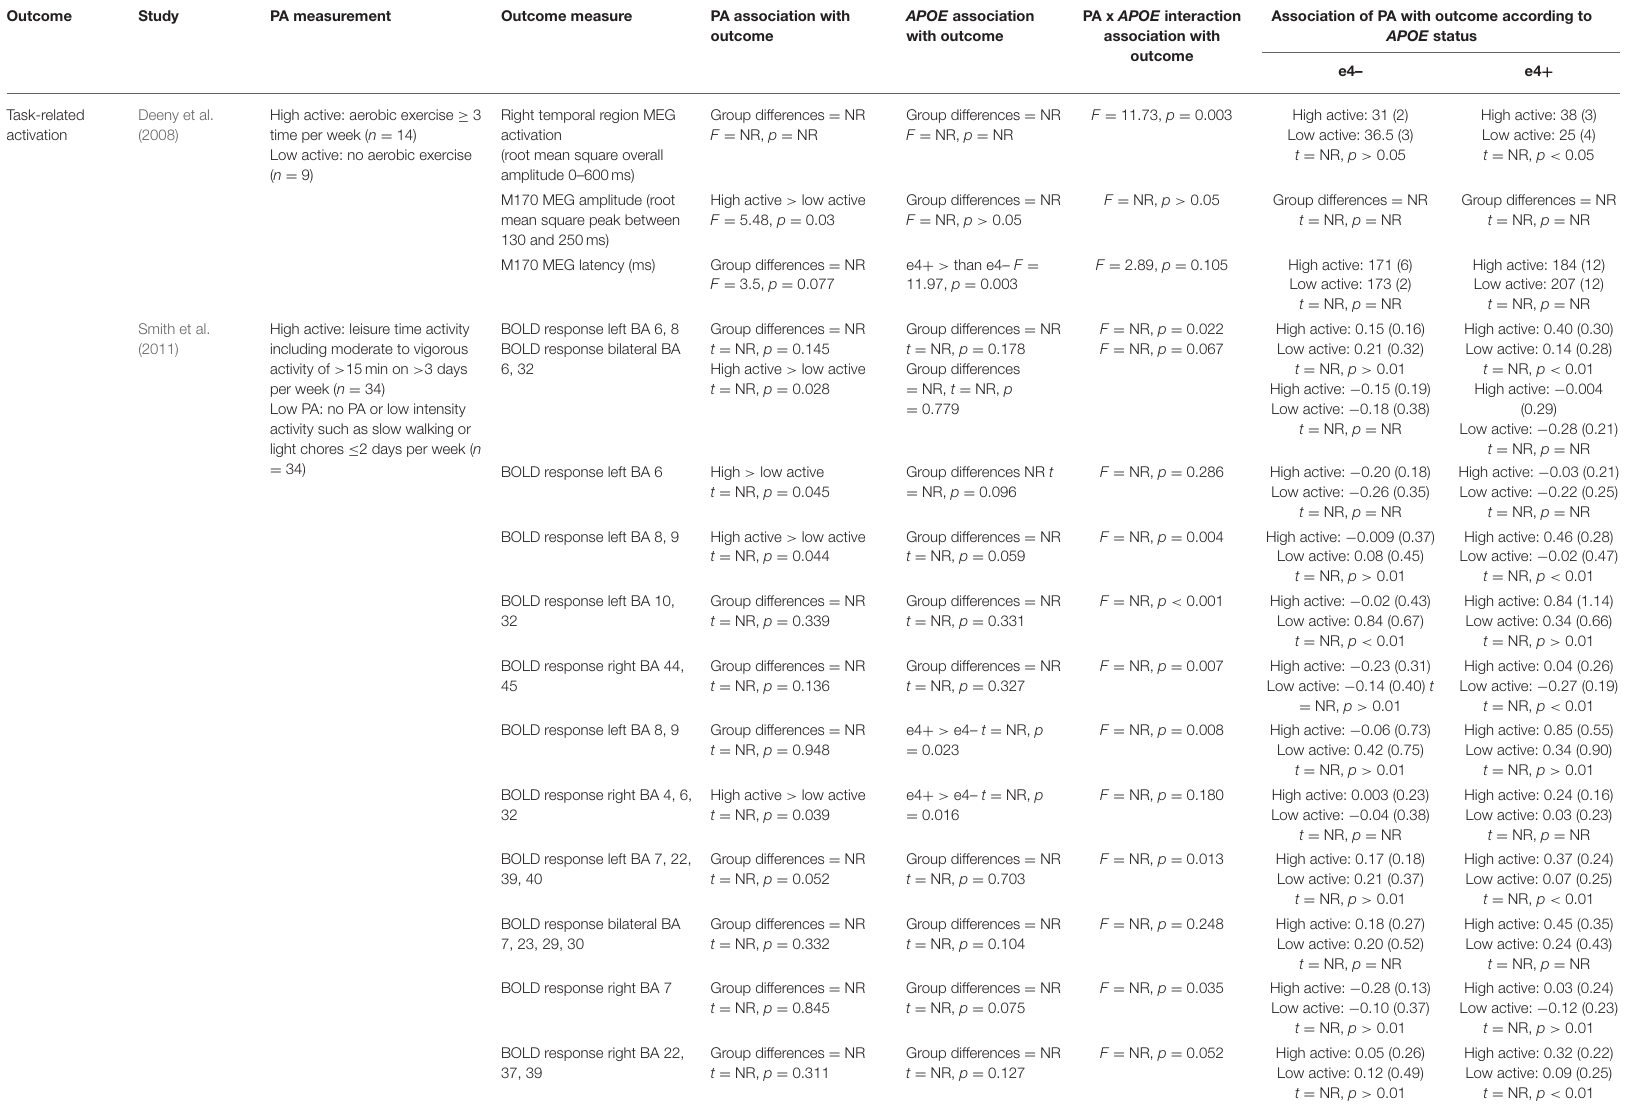
TABLE 5 | Associations between physical activity and functional brain